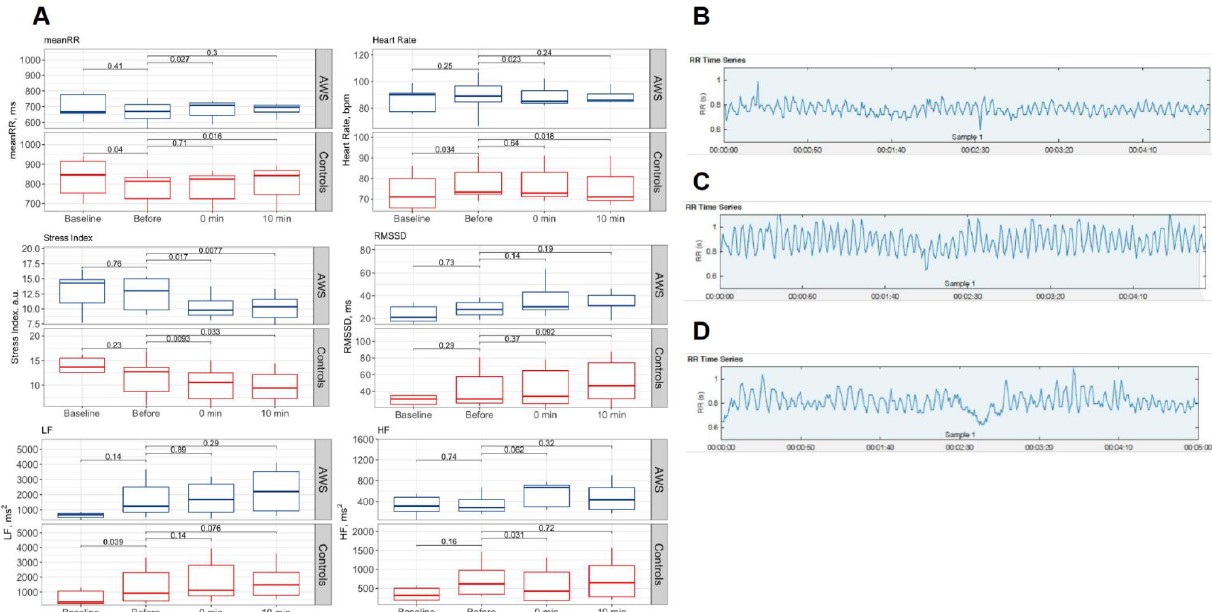
Figure 2. ECG-based markers of stress during reading tests. ( A ) HRV markers (meanRR, heart rate, stress index, RMSSD, LF, and HF) are shown for AWS and control group in baseline rest state, reading before the stimulation, immediately after (0 min), and 10 min after the binaural beats stimulation. RR intervals deviation with time demonstrate HRV characteristics before stimulation ( B ), right after stimulation ( C ), and 10 min after stimulation ( D ). Note an increase in amplitude and higher frequencies alongside with reduction in regularity of oscillations exemplifying physiologic relaxa-